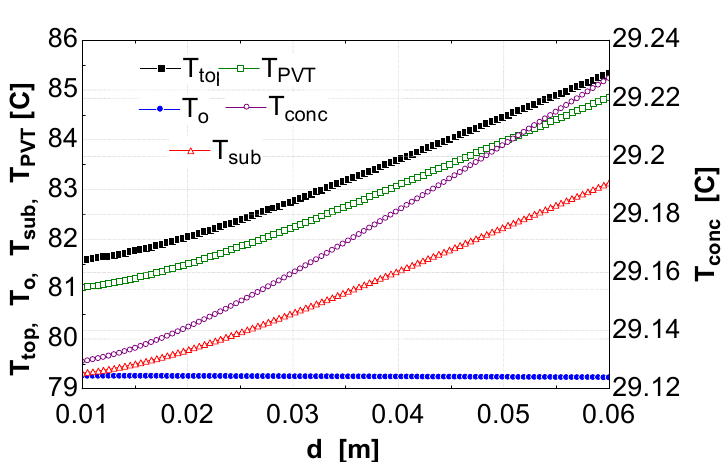
Figure 8. CPVT Temperatures vs. channel